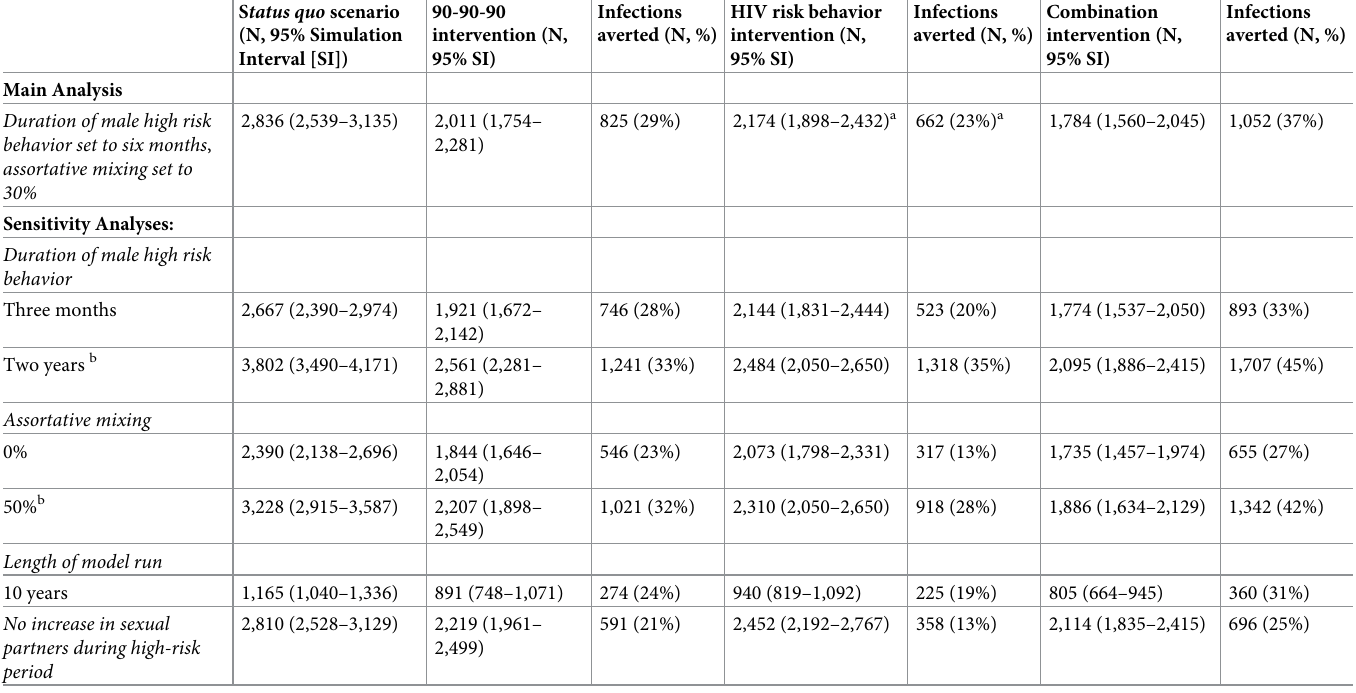
Table 2. Average number of cumulative new HIV infections and mean number of averted HIV infections among African American women over 20-year period by